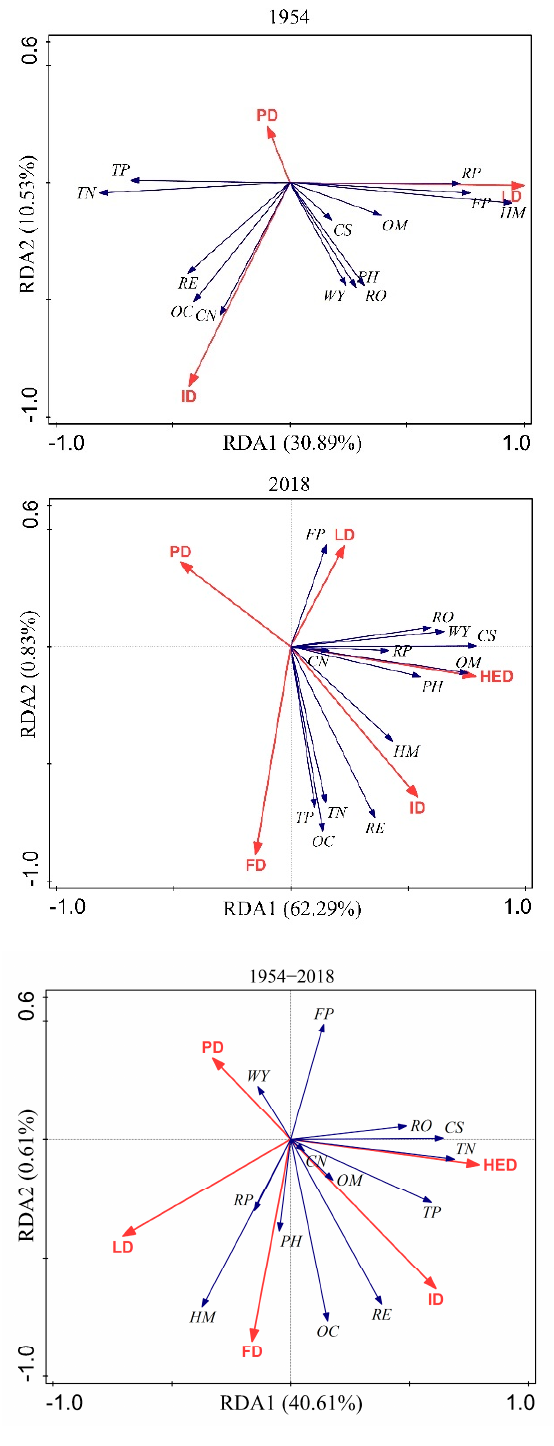
Figure 6. Redundancy analysis of ES (blue) and human modification drivers (red) in a different single year or the change of two-time steps (1954, 1983, 2018, 1954–1983, 1954–2018). The angles between arrows represent the strengths of the correlations between ES and human modification